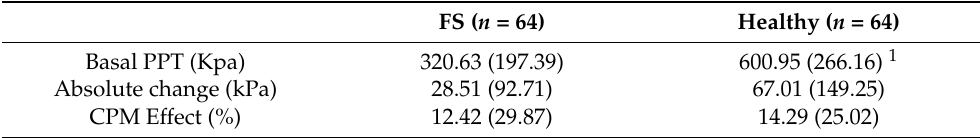
Table 2. Pressure pain thresholds, absolute change, and conditioned pain modulation effect values in individuals with frozen shoulder and healthy